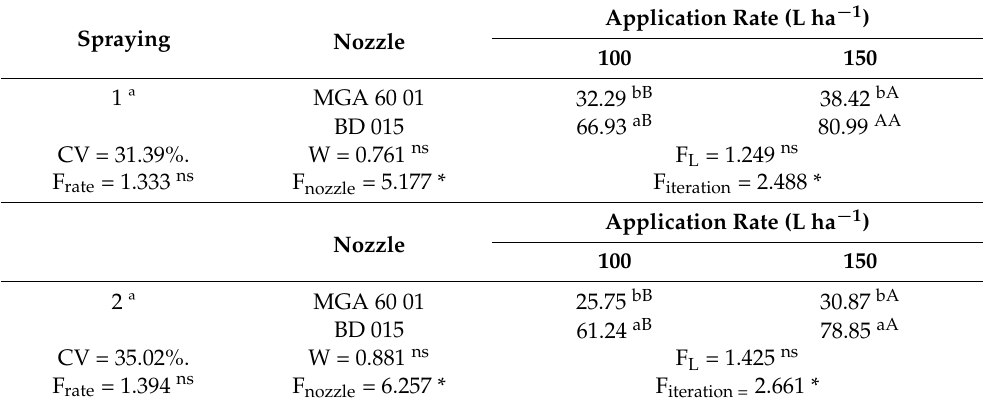
Table 1. Average values of deposited droplet density (droplets cm − 2 ) after spraying with sunscreen on the leaves of conilon coffee seedlings at 7 (1st) and 30 (2nd) days after planting in pots in the field. Application Rate (L ha − 1 Spraying Nozzle